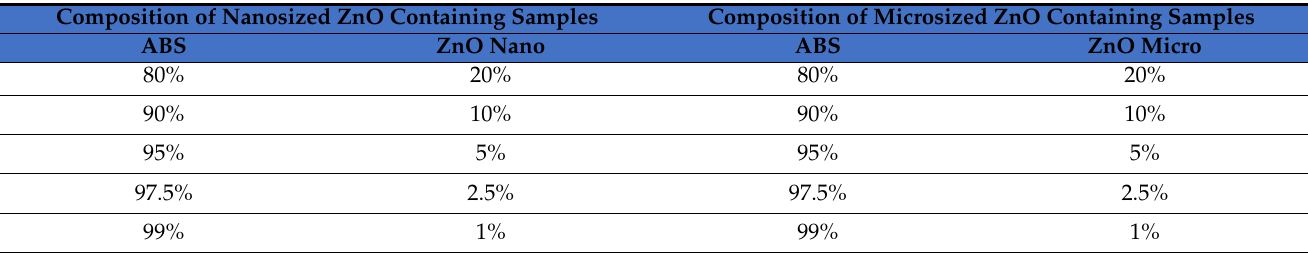
Table 1. ABS and ZnO contents in the two types of 3D-printed composite materials. Composition of Nanosized ZnO Containing Samples Composition of Microsized ZnO Containing